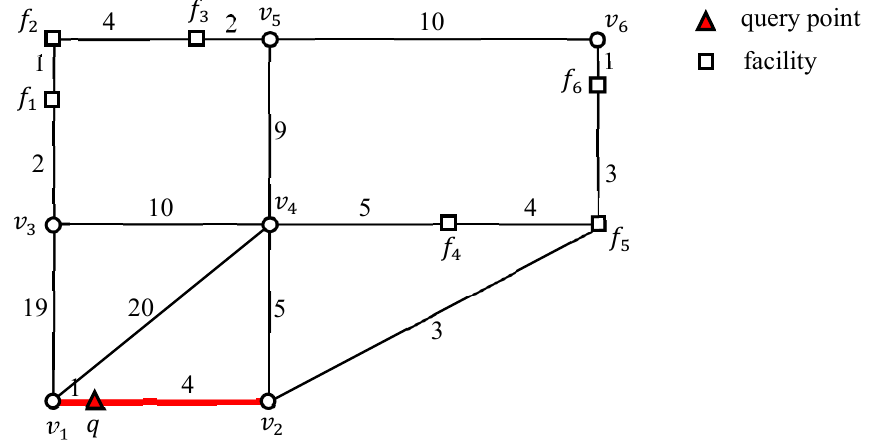
Figure 3. Example of an M k FN query q in a road network.